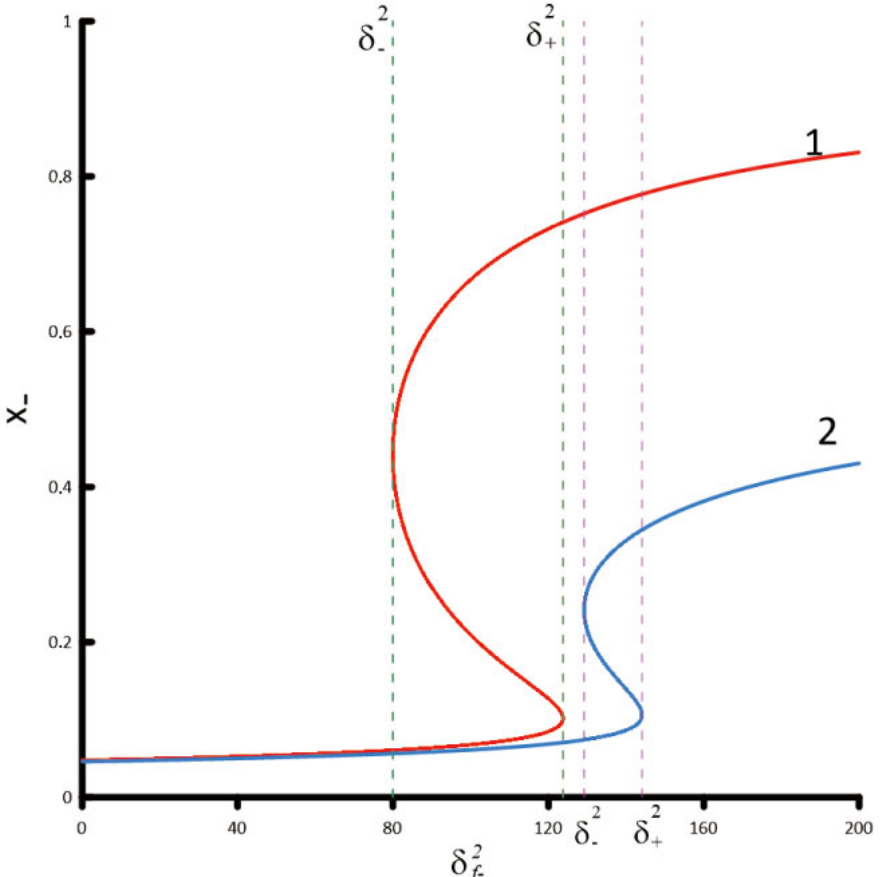
f − parameter for the energy of the initial gamma quantum E = 500 MeV ( " = 5, ω = 100 MeV ) . Line i i thr